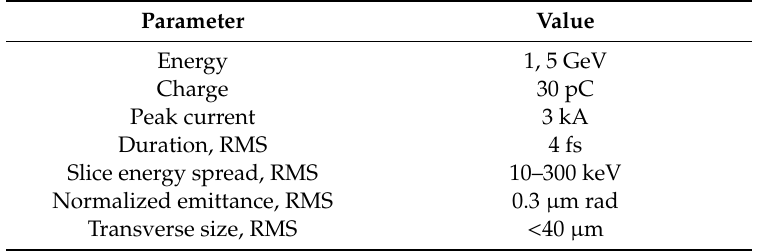
Table 1. Electron beam parameters at the exit of the plasma accelerator.